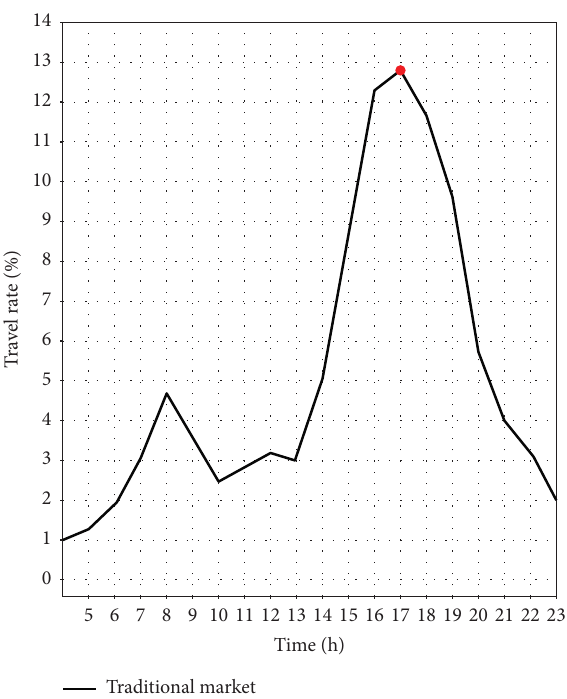
Figure 10: Hourly travel rate of cluster 2.